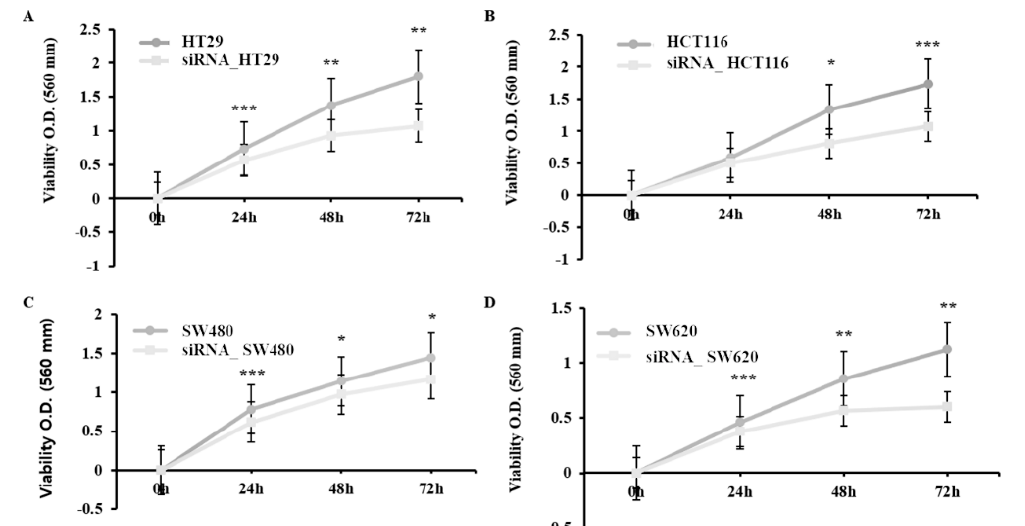
Figure 4. HJURP depletion impairs cell proliferation in colorectal cancer cell lines. Control or HJURP- siRNA colorectal cancer cell lines such as HT29, HCT116, SW480, and SW620 were analyzed every 24